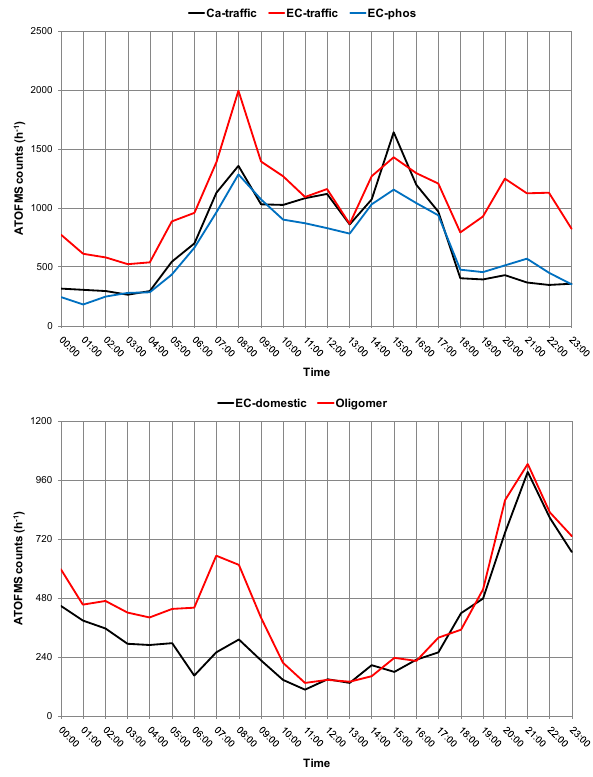
Fig. 11. Average diurnal trend for (top) Ca-traffic, EC-traffic and EC-phos and (bottom) EC-domestic and Oligomer particle counts for 7–28 August 2008. EC-phos and EC-domestic particle num- bers have been multiplied by a factor of 3 and 1.5 respectively for comparative